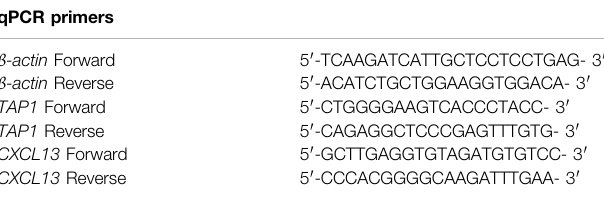
TABLE 1 | Primers used in the